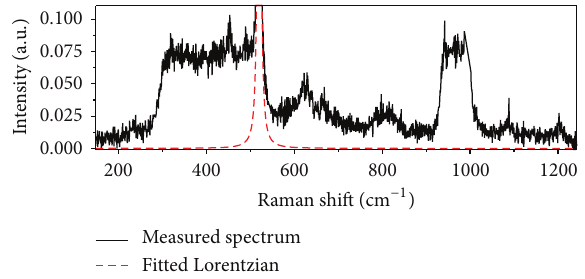
Figure 1: Raman spectrum measured for Si/SiO 2 sample, excitation wavelength 266 nm. Black solid line represents measured data; dashed red line represents fitted Lorentzian profile modeling one- phonon Si